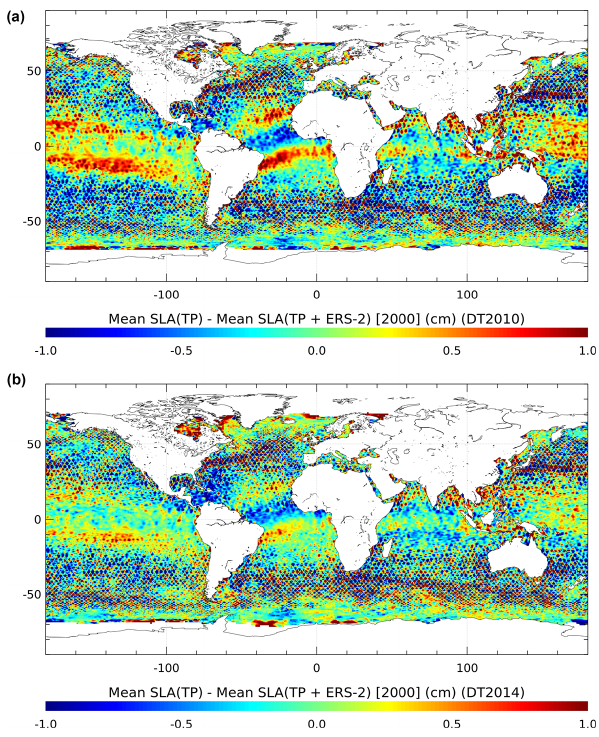
Figure 16. Difference of the mean SLA over the year 2000, mea- sured with TP only, and with the merged TP + ERS-2 product. Com- parison done for the DT2010 (a) and DT2014 (b)